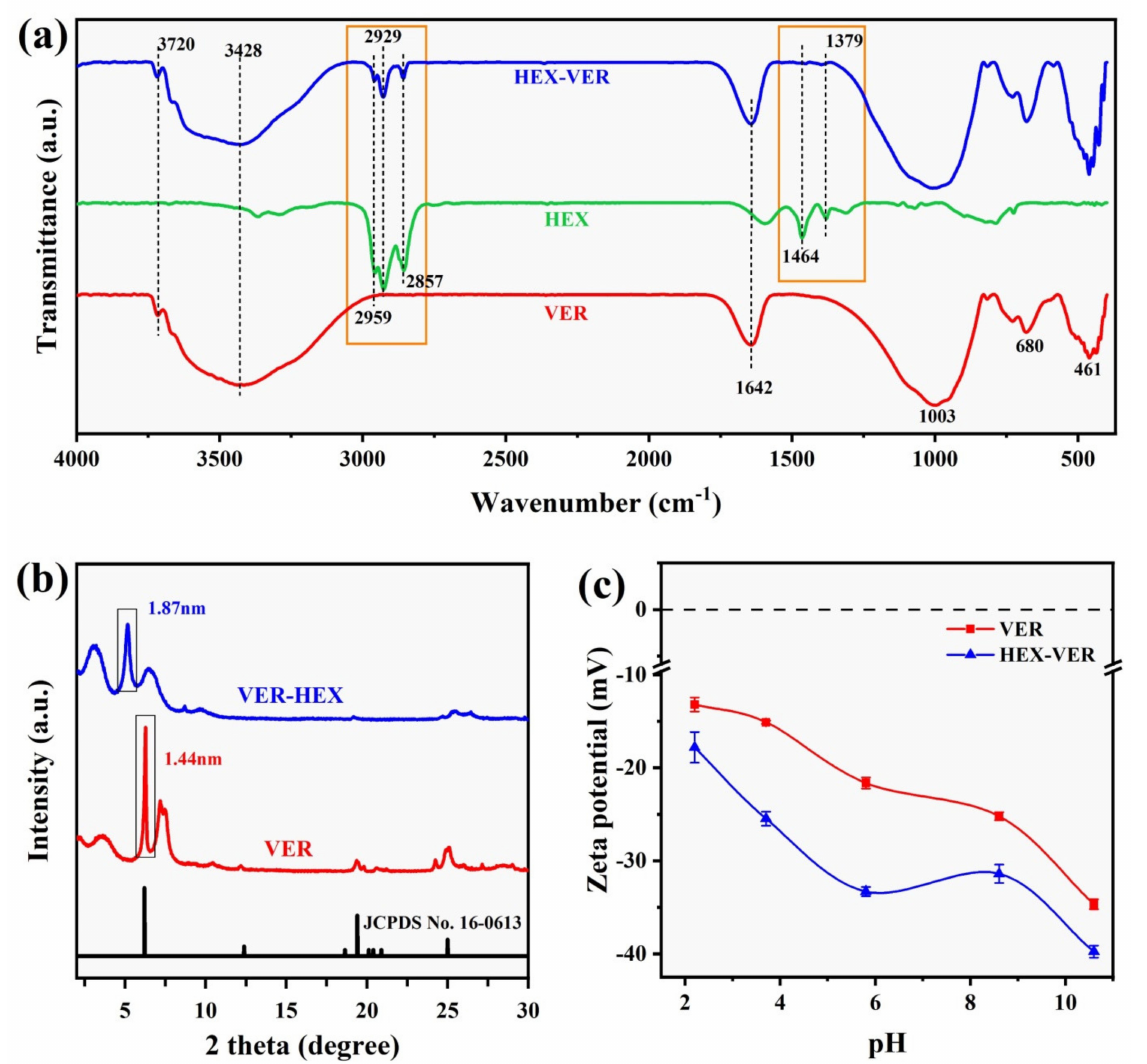
Figure 1. FTIR ( a ), XRD pattern ( b ), and zeta ( ζ )/electrical potential ( c ) of VER and